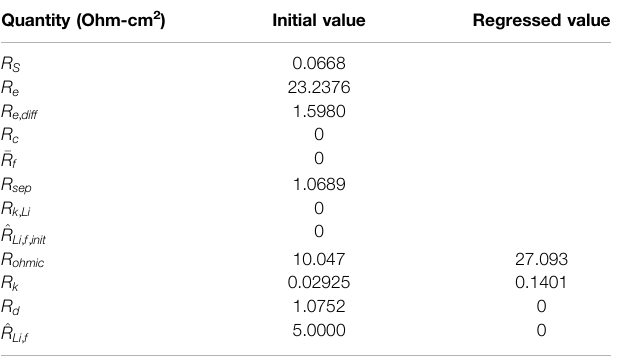
TABLE 5 | Initial and regressed sheet resistances. See Eq. 73 for the cell resistance expression. Quantity (Ohm-cm 2 )